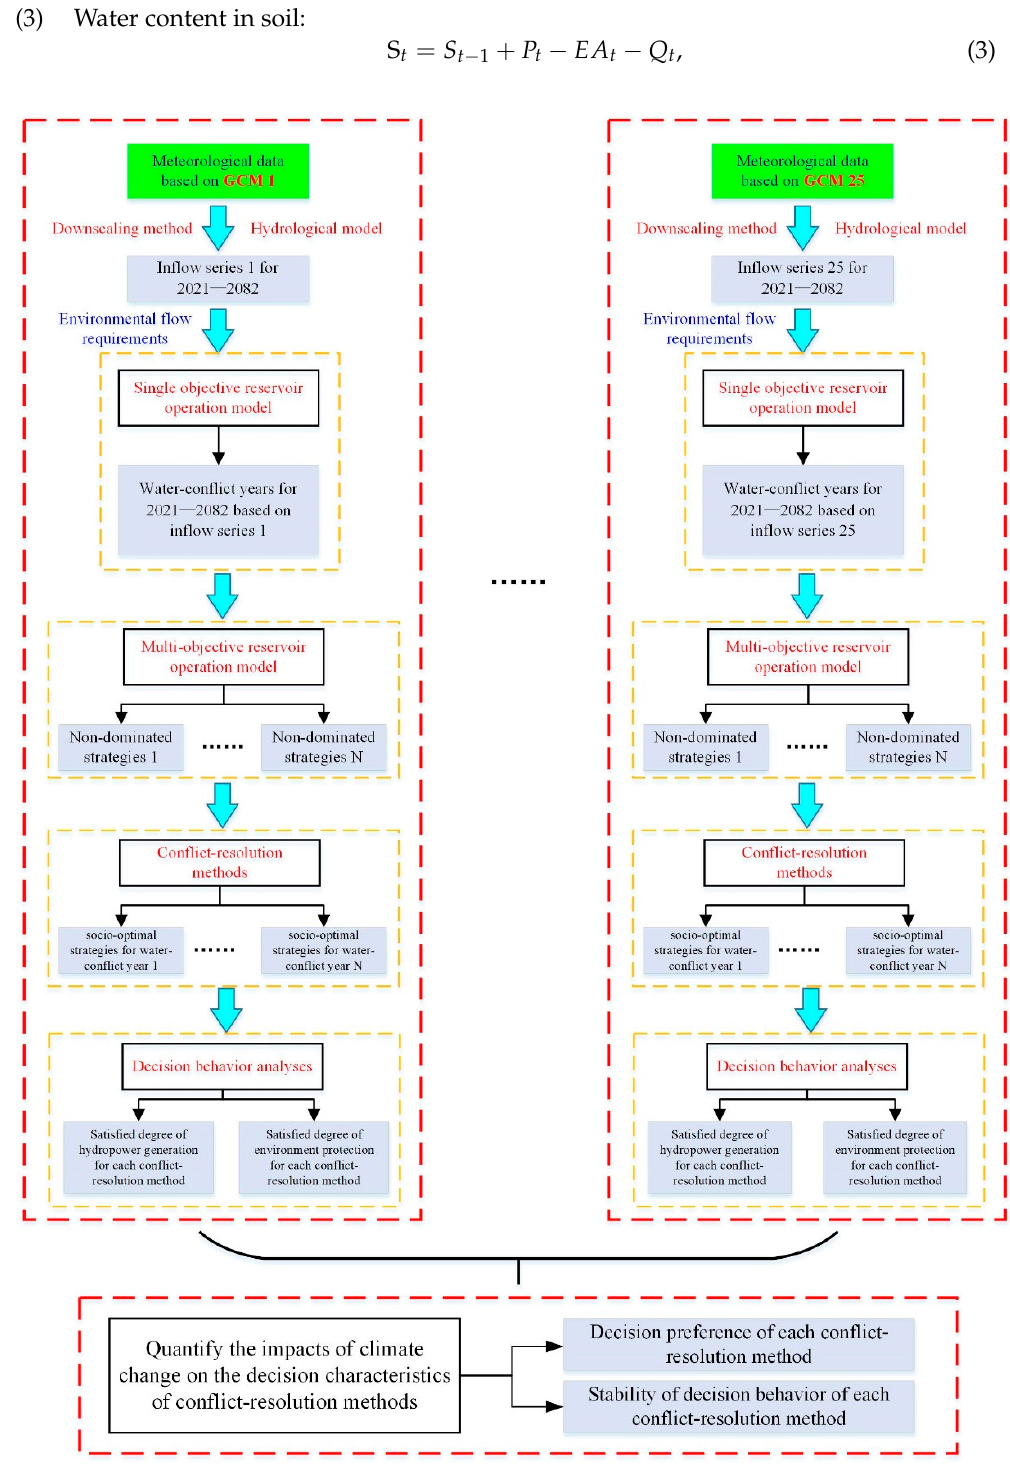
Figure 1. Flow chart of methodology.